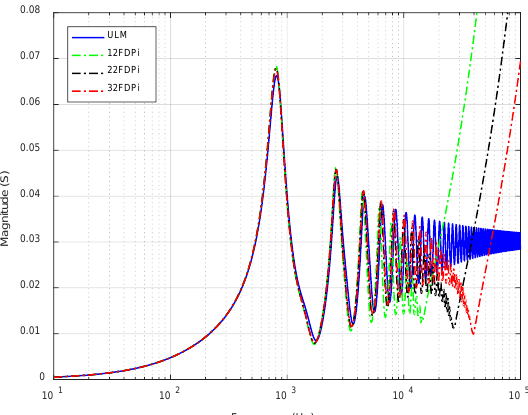
Figure 8. Cable admittance comparison for Case Study #1 with different number ( N ) of cascaded FDPi sections.